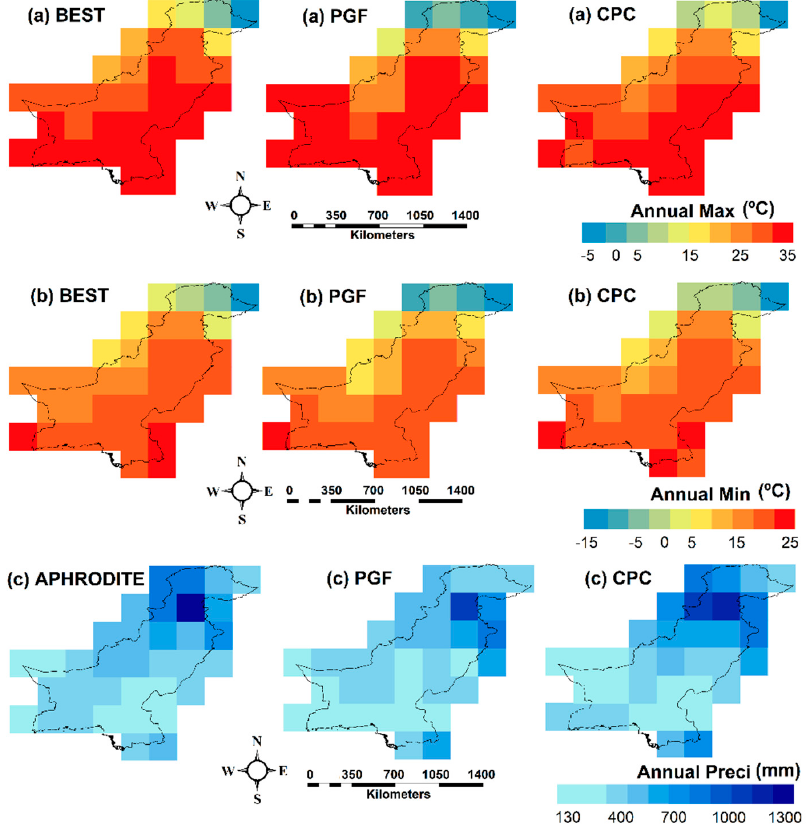
Figure 2. Spatial distribution of annual average of daily ( a ) maximum temperature; ( b ) minimum temperature; and ( c ) annual total rainfall estimated using different gridded temperature and rainfall data.